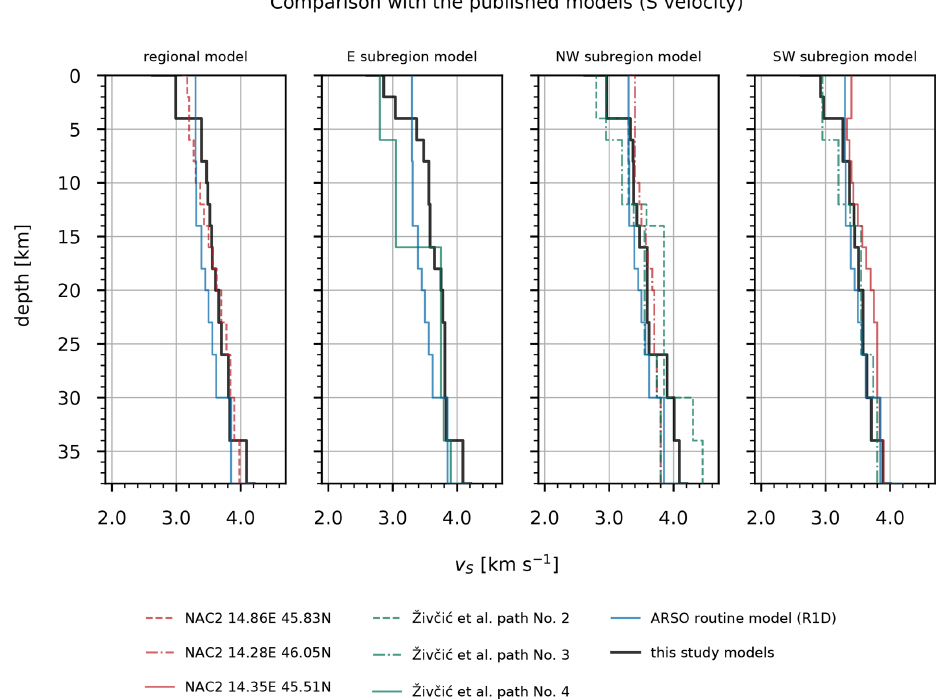
Figure 17. Comparison of the S velocities obtained in this study (black lines) with the published models of Magrin and Rossi (2020), Živˇci´c et al. (2000), and the routine (R1D) model. Models based on the results of Magrin and Rossi (2020; NAC2) were extracted at the point closest to the respective reference seismic station. For easier comparison, all published models were extracted by calculating the weighted average of the velocities in each